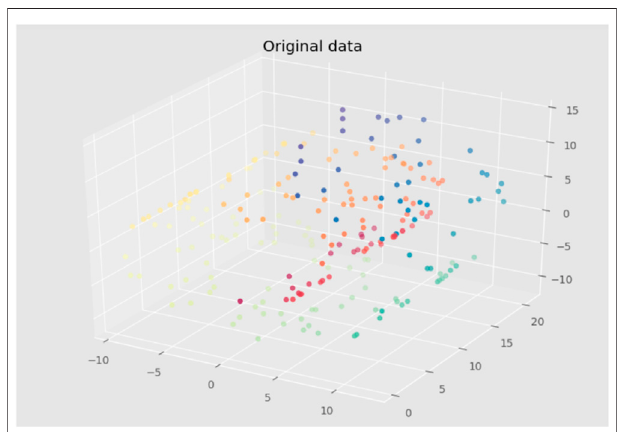
FIGURE 6 | Sample structure of plans studied in three-dimensional space, Source: Author.